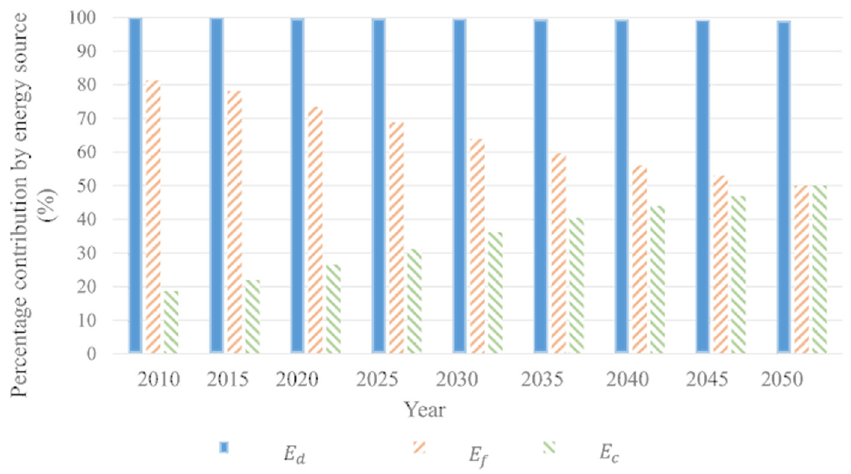
Figure 5. Governmental objectives to satisfy in General Climate Change Law (GCCL). Prepared by the authors based on data from cited reference [10].